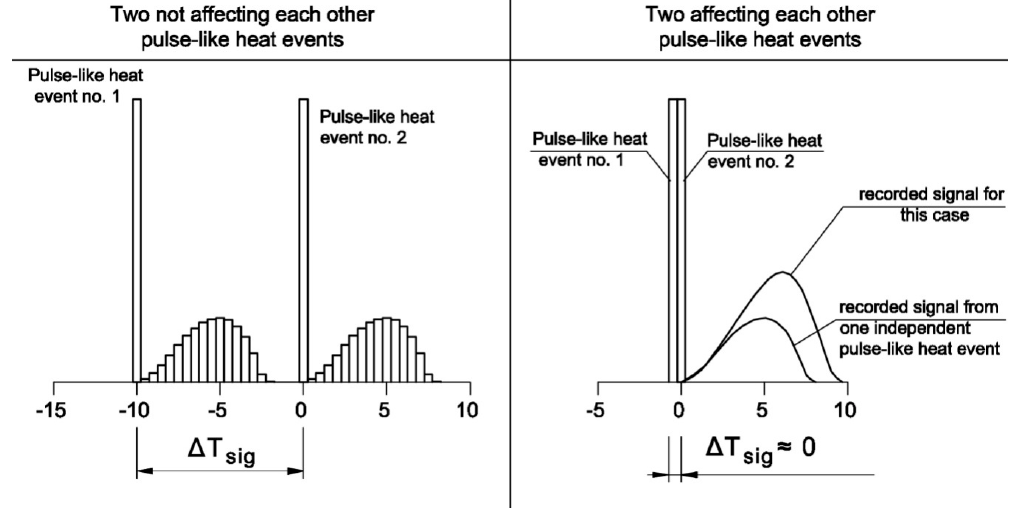
Figure 5. Signals recorded for thermal pulses far away from each other and when the pulses nearly overlap.